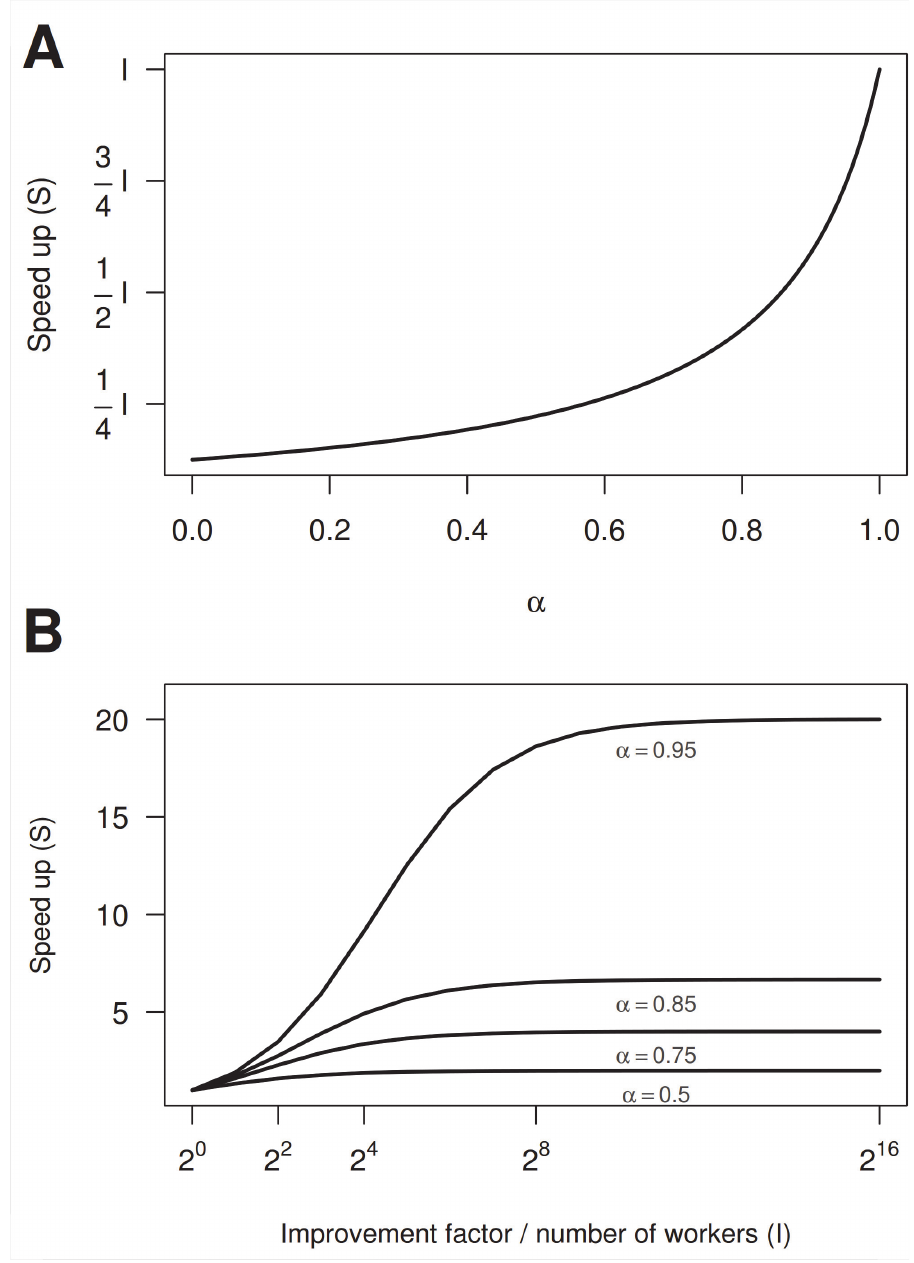
Fig 3. Projected improvements in total program run time using Amdahl's law. ( A ) Realized total speed up when a section of code, taking up a fraction α of the total run time, is improved by a factor I (i.e., the expected program speed-up when the focal section runs I times faster). We see that optimization is only effective when the focal section of code consumes a large fraction of the total run time ( α ). (B) Total expected speed-up gain for different levels of α as a function of I (e.g., the number of parallel computations). Theoretical limits exist to the maximal improvement in speed, and this is crucially and asymptotically dependent on α — thus code optimization (and investment in computation hardware) are subject to the law of diminishing returns. All predictions here are subject to the scaling of the problem (S1 Text, section